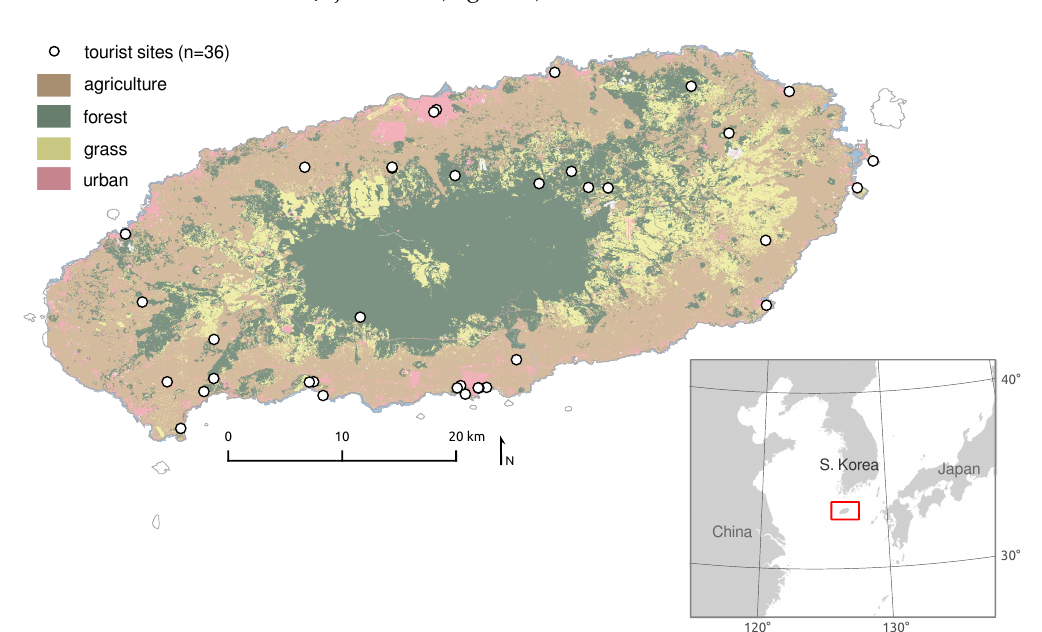
Figure 1. Jeju Island, South Korea. Dots show locations of 36 tourist sites for which on-site visitor counts were compared to visitation measured from